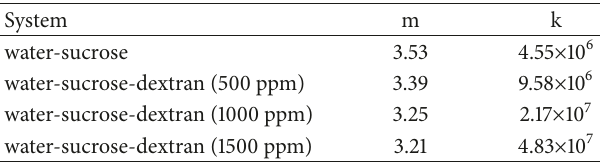
Table 3: Nucleation kinetic parameters estimation.